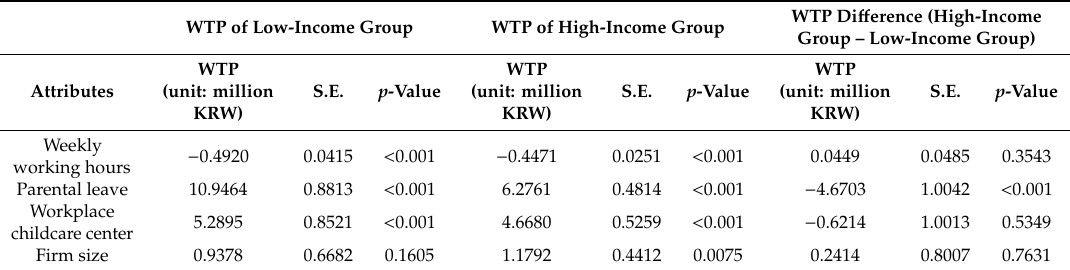
Table 12. WTP for workplace attributes, by income level.